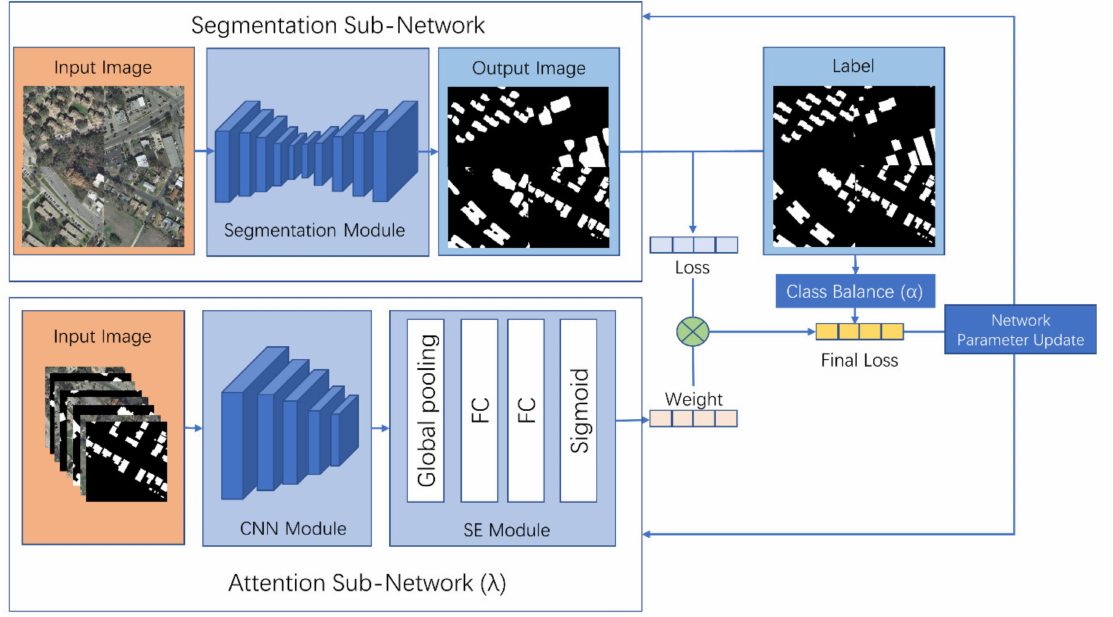
Figure 4. The overall structure of the proposed Weighted Loss Network